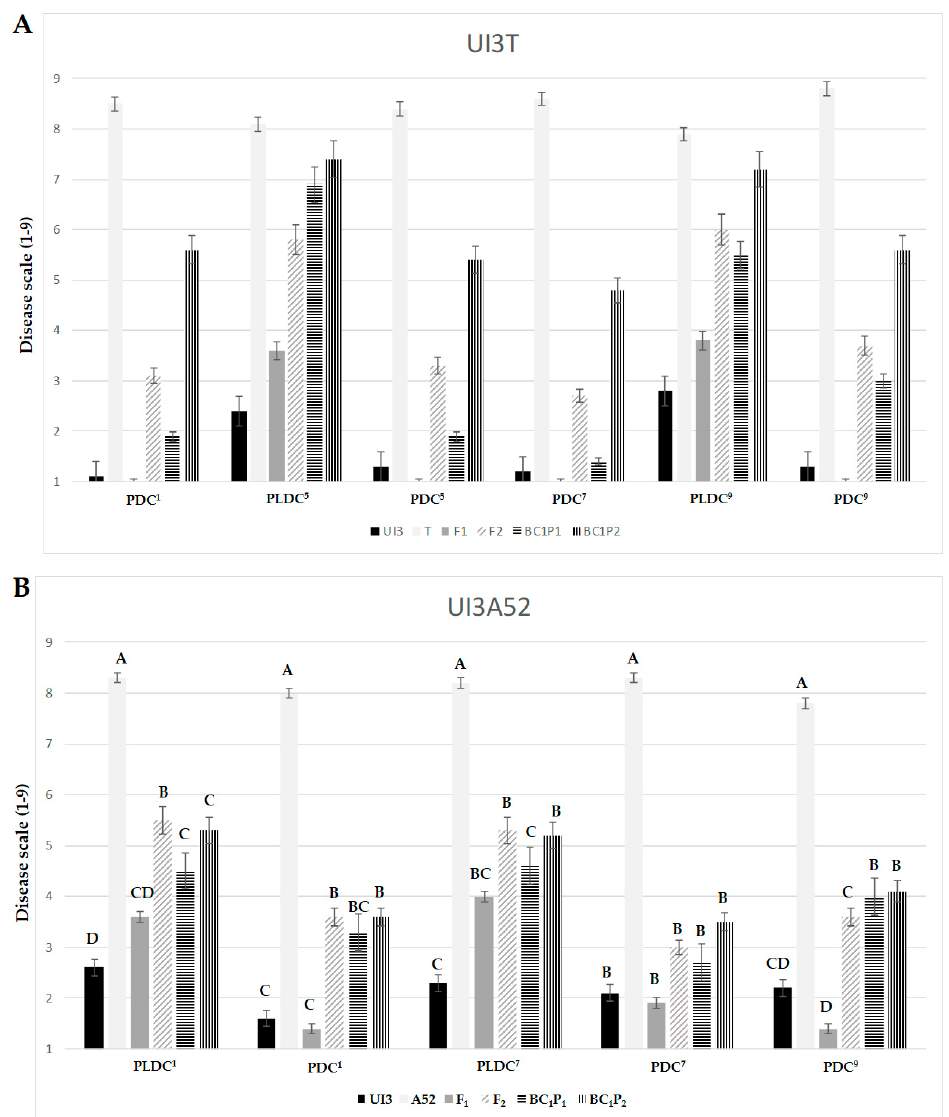
Figure 1. Generation mean comparison of DC for primary leaf and pod resistance to halo blight races 1, 5, 7 and 9 for the UI3T ( A ) and UI3A52 ( B ) segregating generations. Mean values with the same letter are not significantly different ( p ≤ 0.05). PDC = pod disease score; PLDC = primary leaf disease score. Numerical superscripts refer to the race tested. The two primary (unifoliate) leaves of bean plants were inoculated with races 5 and 9 in UI3T and with races 1 and 7 in UI3A52 segregating generations.